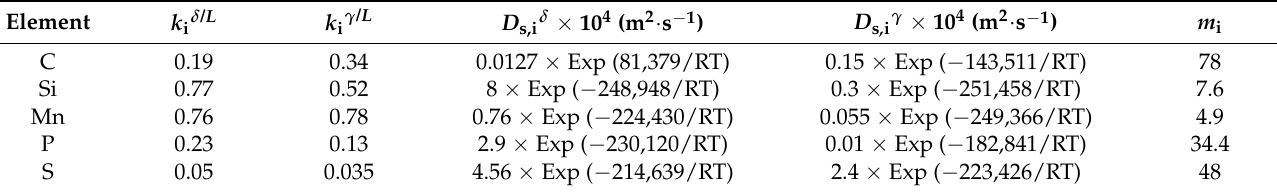
Table 1. Solidification parameters (R = 8.314 J/mol/K)